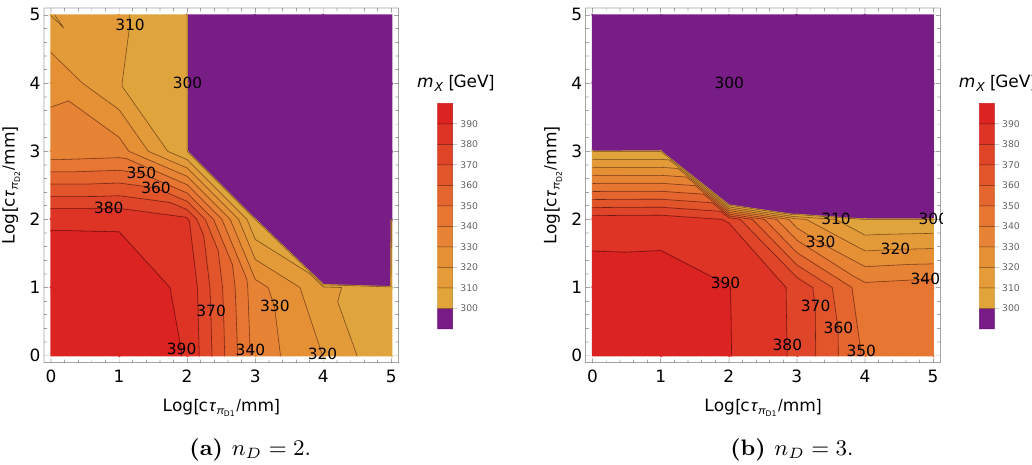
Figure 9. Same as figure 7, but for the four jet